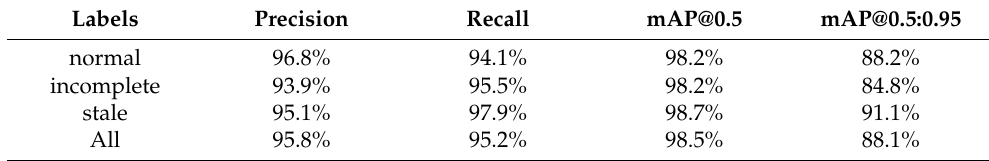
Table 3. The training results of the model include precision, recall, mAP@0.5, and mAP@0.5:0.95.